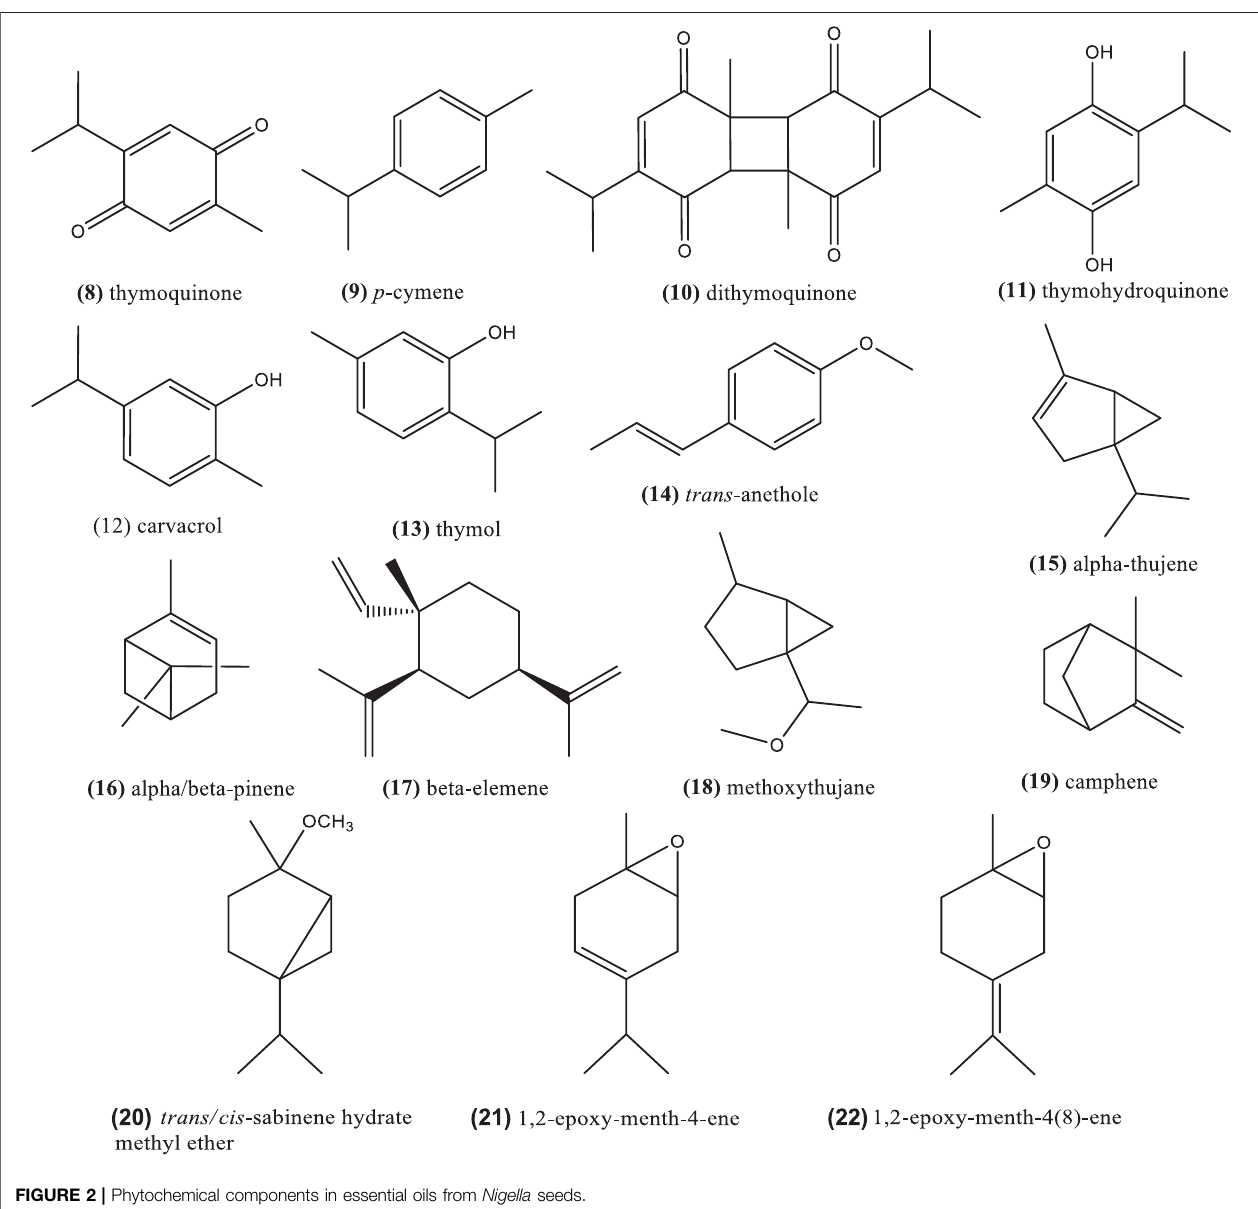
FIGURE 2 | Phytochemical components in essential oils from Nigella